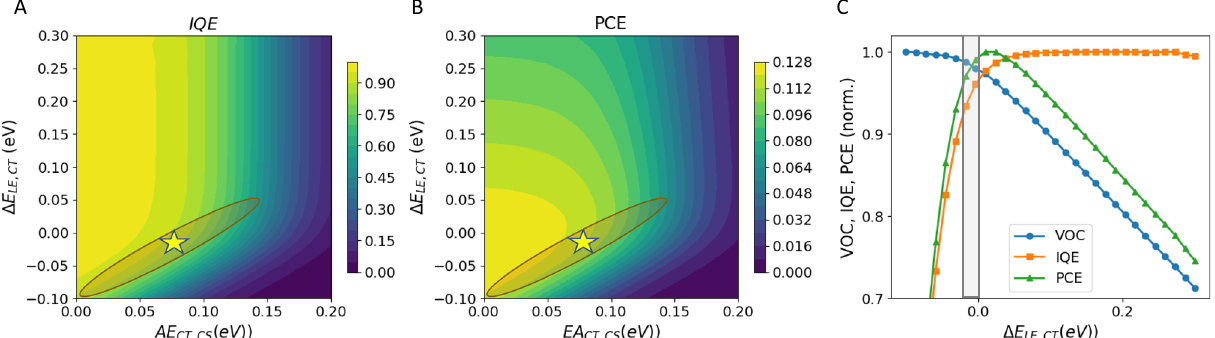
Fig. 4 Multi-objective modelling. a IQE and ( b ) PCE as a function of the driving force for exciton splitting Δ E LE ; CT and the activation energy for charge separation AE CT ; CS shown in a false colour scale in a 30 × 30 grid. At each grid point, the charge extraction and Langevin constants were optimized so that the numerical model (see Supplementary Information, Eq. (S17) – (19)) best reproduced the three experimental observations: yellow star marks global optimum; orange stripe marks valley of local optima. c Vertical cut through panels ( a ) and ( b ) and of the corresponding graph for V OC , shown in Supplementary Fig 13, at AE CT ; CS ¼ 0 : 075eV, normalised to the respective maxima. Grey rectangle marks the position of the local minimum for the multi- objective optimization, showing that the CT energy of WF3:O-IDTBR is close to the theoretical optimum position, given its speci fi c LE and CT decay constants. This graph is similar for any position along the orange